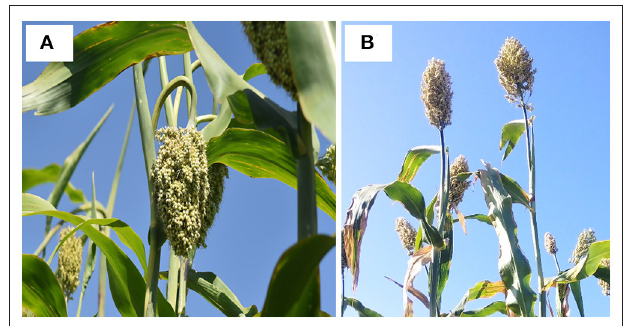
FIGURE 8 | Representative image of the panicle of (A) local sorghum landrace Sevata jonna and (B) open-pollinated dual-purpose sorghum variety Phule